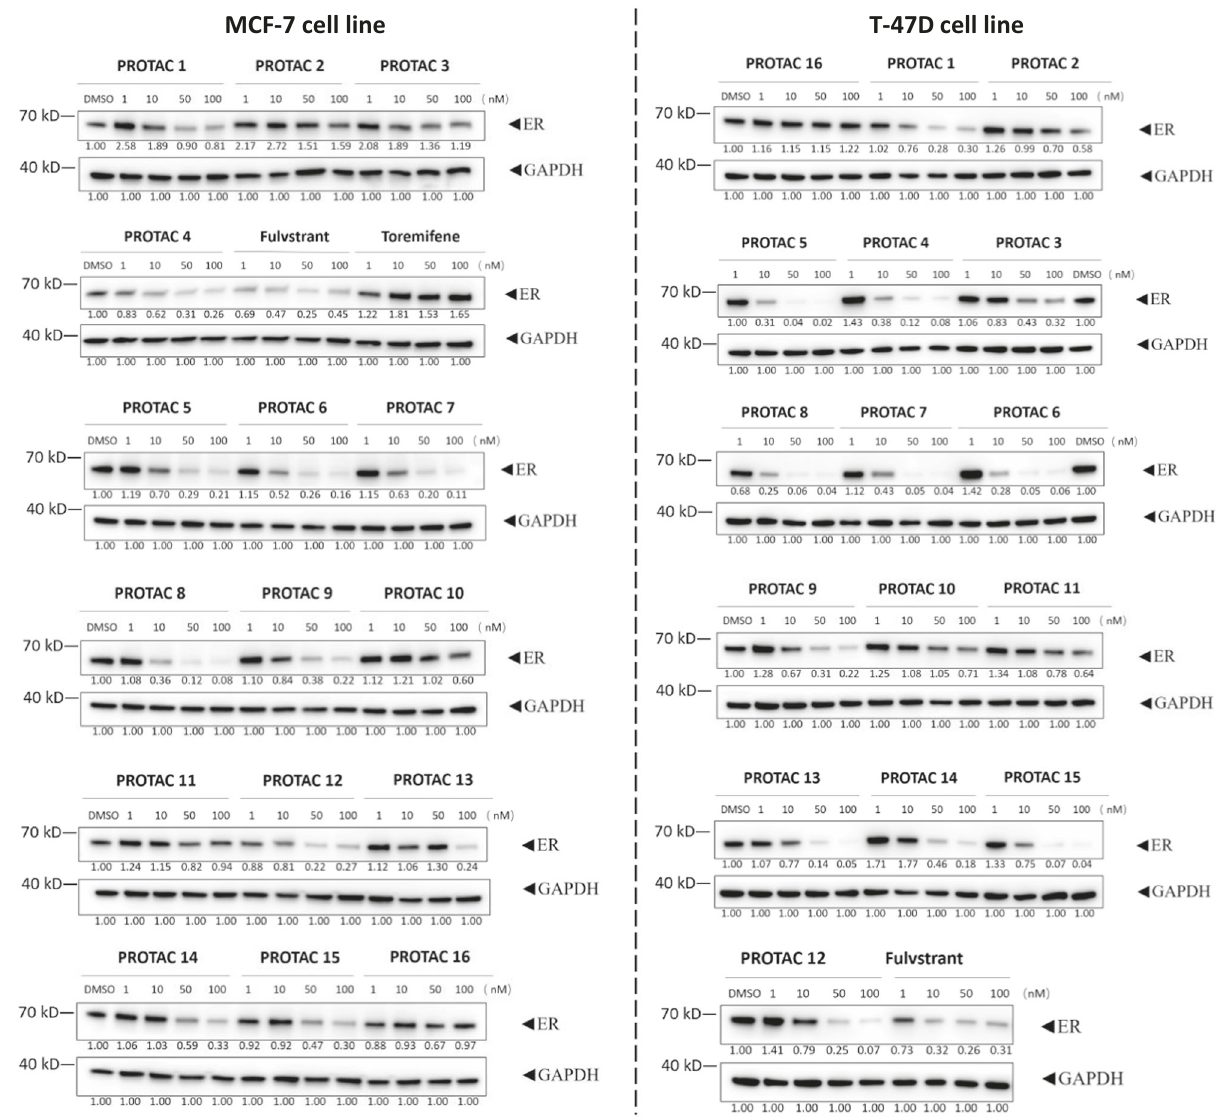
Fig. 6 | Western blotting analysis and densitometry quanti fi cations of ERprotein. TheMCF-7andT-47Dbreastcancercelllinesaretreatedwithindicated compounds at 1, 10, 50 and 100 nM for 16 h. The densitometry quanti fi cations are